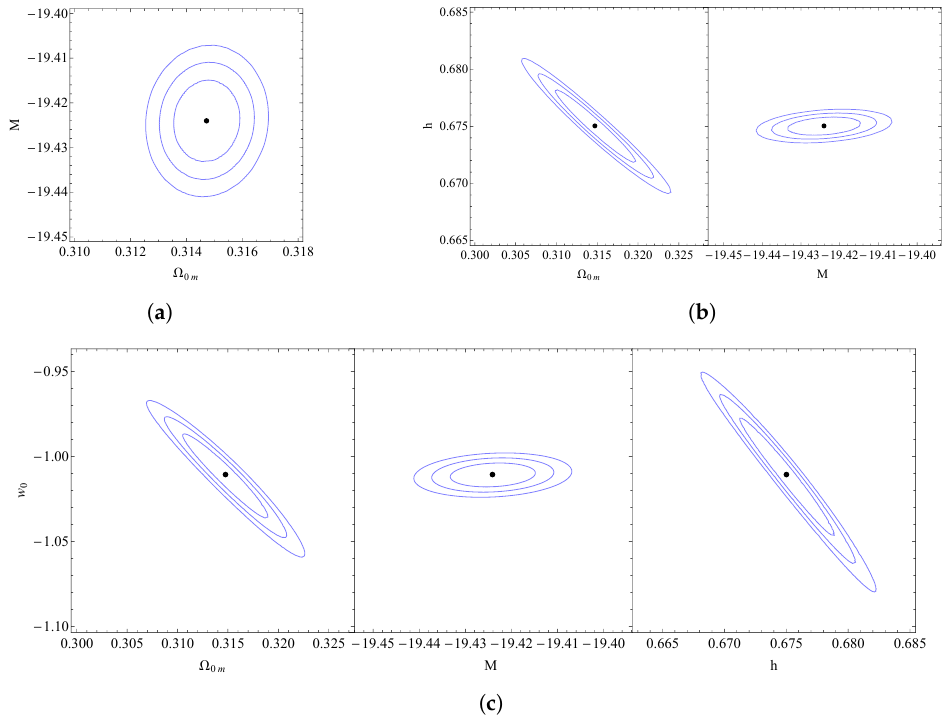
Figure 17. Confidence contours for the wCDM model: ( a ) The 1 σ − 3 σ confidence contour in the parametric space ( M − Ω 0 m ) . ( b ) The 1 σ − 3 σ confidence contours in the parametric spaces ( h − Ω 0 m ) and ( h − M ) . ( c ) The 1 σ − 3 σ confidence contours in the parametric spaces ( w 0 − Ω 0 m ) , ( w 0 − M ) and ( w 0 − h )